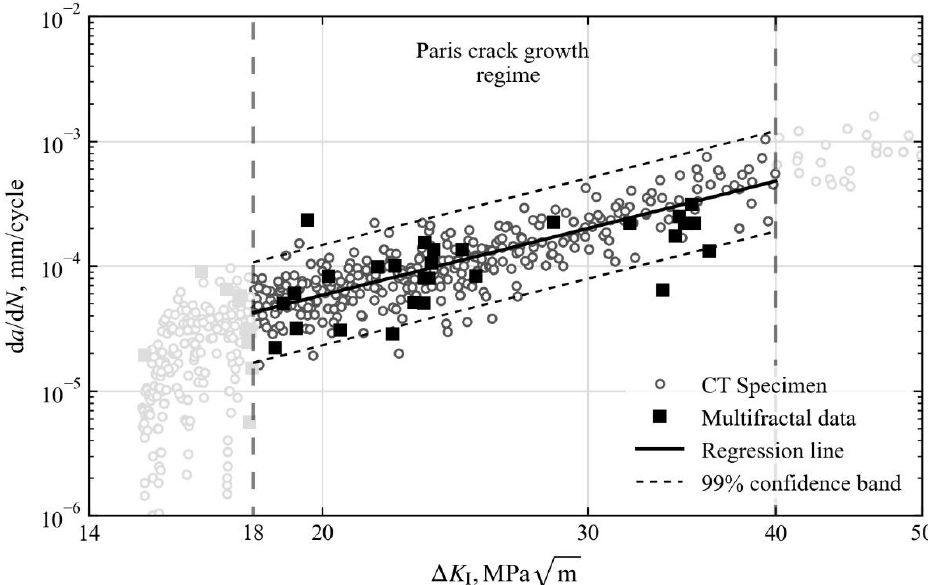
Figure 8. Comparison of fatigue crack growth rate data determined using the multifractal crack growth model with that obtained using the Paris crack growth equation. Grey-colored symbols represent data outside the Paris crack growth regime.